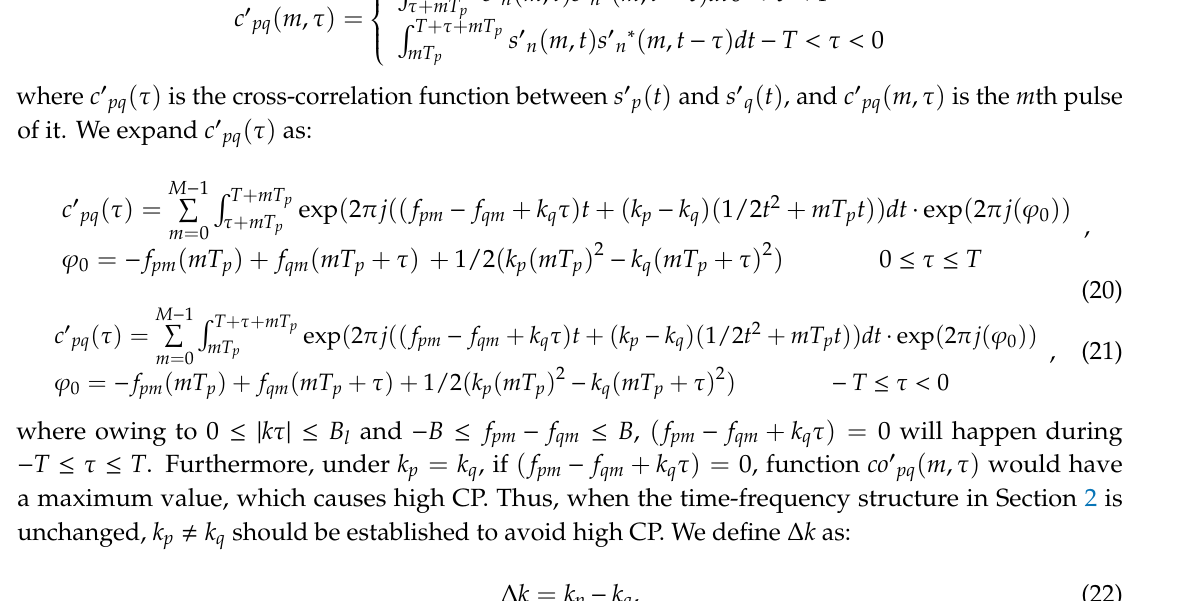
Figure 8. Cross-correlation peaks (CP) curve with